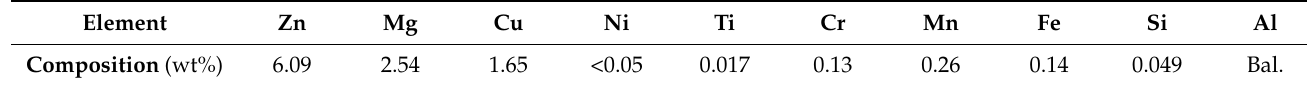
Table 1. Chemical compositions of the 7B04-T74 aluminum alloy.